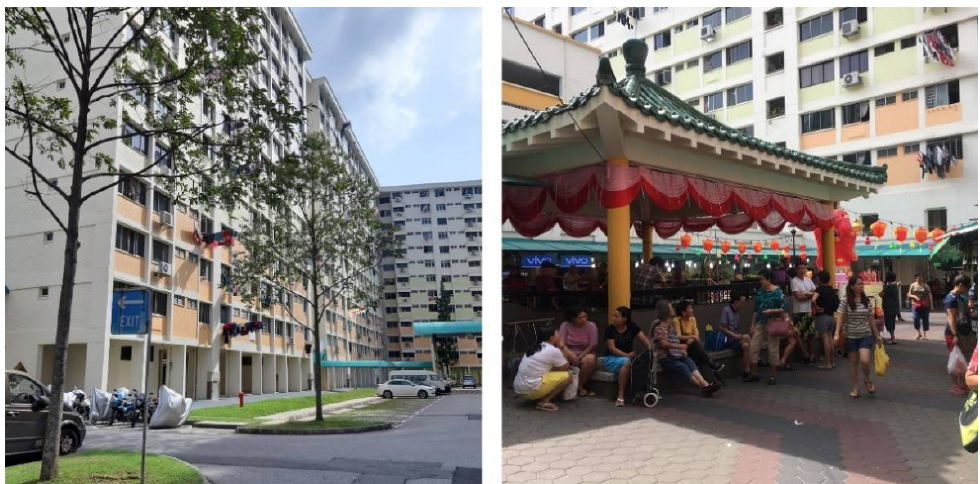
Figure 3. Bangkit neighbourhood: precinct 1 (left); precinct 2 (right) (source: by author).